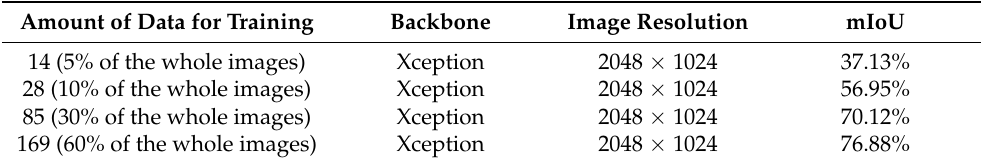
Table 7. Comparison of results with different amounts of training data using the pre-trained network “Xception” with improved hyperparameters.